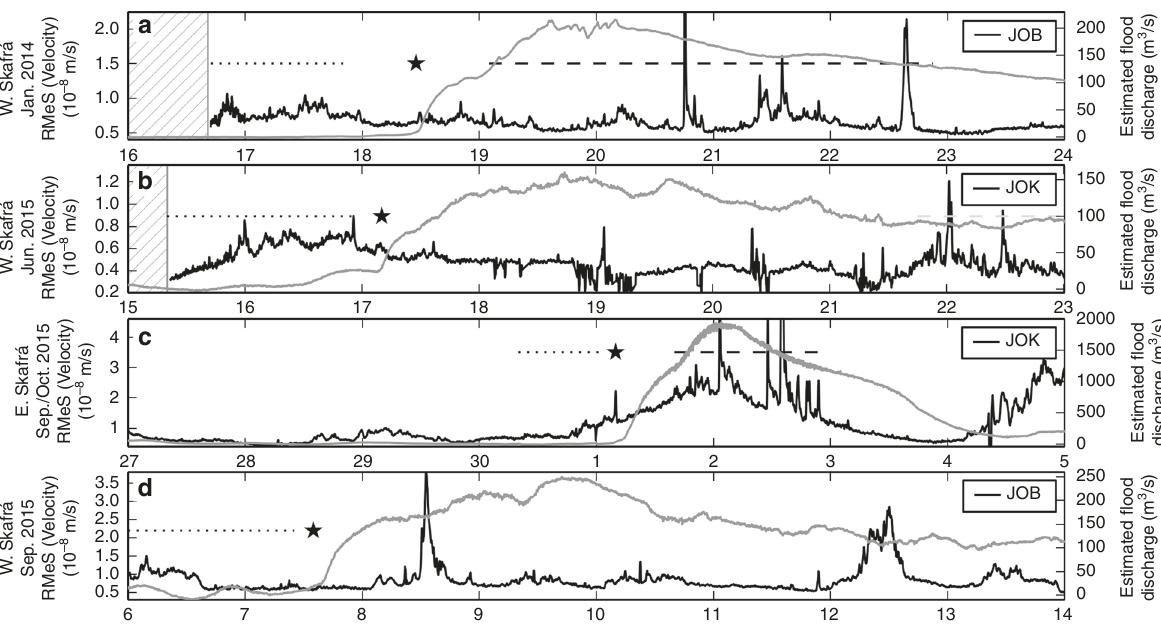
Fig. 6 Summary of tremor and estimated discharge during all four fl oods. The fl oods occurred in a January 2014, b June 2015, c September/October 2015 and d September 2016. Hatched areas mark data gaps. Root Median Square (RMeS) (black) of the seismic ground motion recordings at station JOK or JOB in JO array was fi ltered between 1.3 and 4 Hz. The station with the least data gaps is shown alongside the estimated fl ood discharge (grey). The star marks the arrival of the fl ood at the uppermost hydrological station. Dotted lines mark the time period when the tremor source is propagating southwards using JO array during Skaftá fl oods (Type 1 tremor), dashed lines mark time periods of high-frequency tremor with harmonic character (Type 2 tremor).